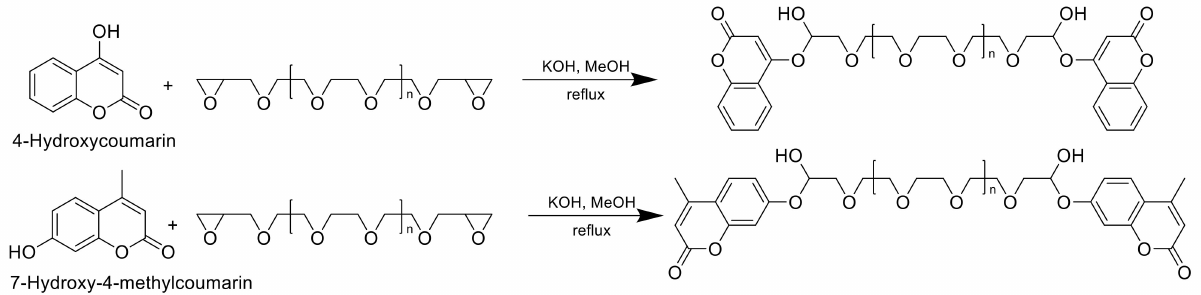
Figure 27. Functionalization of oligoethylene glycol diglycidyl ethers with 4-hydroxycoumarin and 7-hydroxy-4-methylcoumarin.